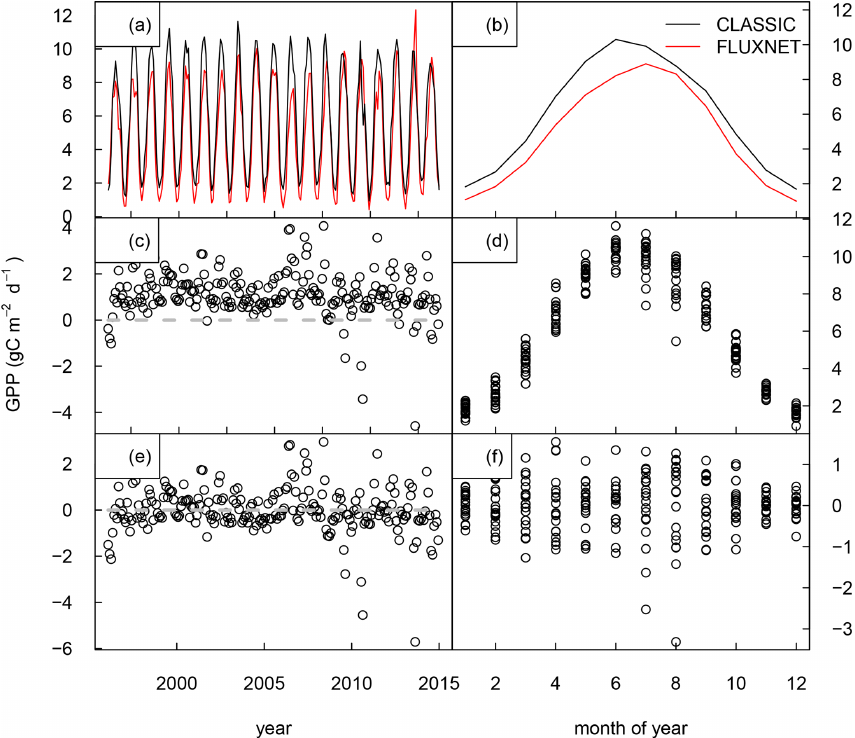
Figure A2. The left-hand column shows monthly values of (a) modeled (black) and observed (red) gross primary productivity, (c) residuals, and (e) residuals of the anomalies. The right-hand column gives the corresponding model values for the (b) climatological mean seasonal cycle, (d) monthly variability, and (f) monthly variability of anomalies. The data correspond to CLASSIC model output for the location of an eddy covariance measurement site in the Netherlands